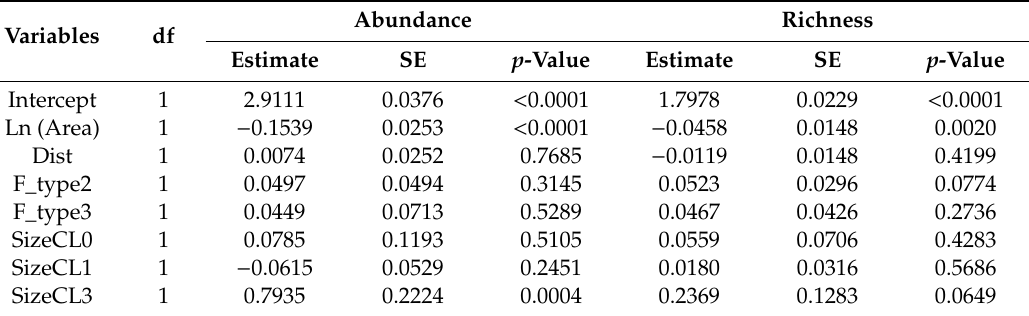
Figure 2. Relationships between forest area and ( a ) abundance and ( b ) species richness. Note that the x-axes for both figures and y-axis for abundance were depicted through logarithmic scales for readability (base: 10). Table 2. Test result (negative binomial regression model) summary for overall species abundance and richness. Notation: df: degrees of freedom; SE: standard error; Ln: natural logarithm; Area: forest area; Dist: distance to forest edge; F_type: forest type; SizeCL: tree size class (for further details, refer to Table 1 and the main text).